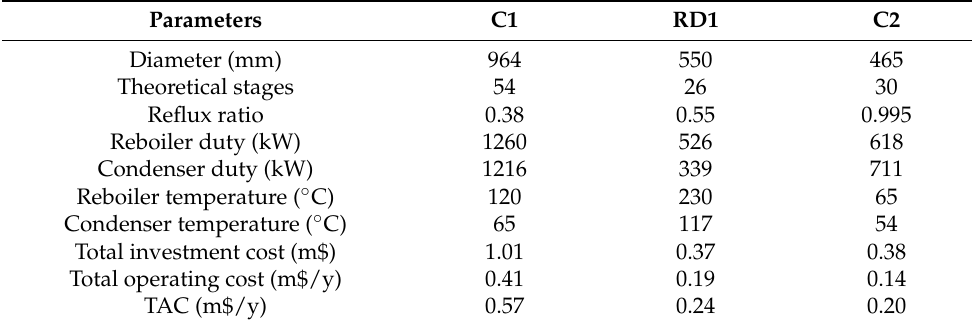
Table 2. Basis and details of equipment sizing for the base case process.